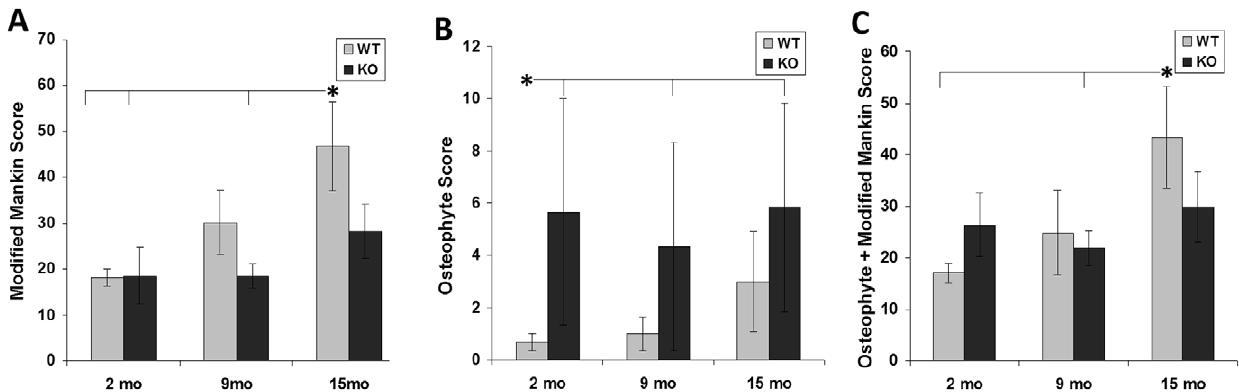
Figure 7. Effects of genotype on cartilage and joint structure. Cartilage degradation in Col6a1 2 / 2 mice did not significantly increase with age, whereas wild type cartilage increased from 2 to15 months. (A) Bars are mean 6 SEM. Osteophyte score was initially low in Col6a1 + / + mice and trended up with age, whereas severity of osteophytes began and remained high among the Col6a1 2 / 2 mice (B). Median with quartile bars shown. The combination of the two scores showed trends similar to that of the Modified Mankin score (C). Bars are mean 6 SEM. Starred bar connected by notches on horizontal line to multiple bars is different from those values. * p , 0.05, ** p , 0.01. WT= Col6a1 + / + ; KO= Col6a1 2 / 2 . bone content in 4-week-old femurs [57]. Truncation of Col2a1 in